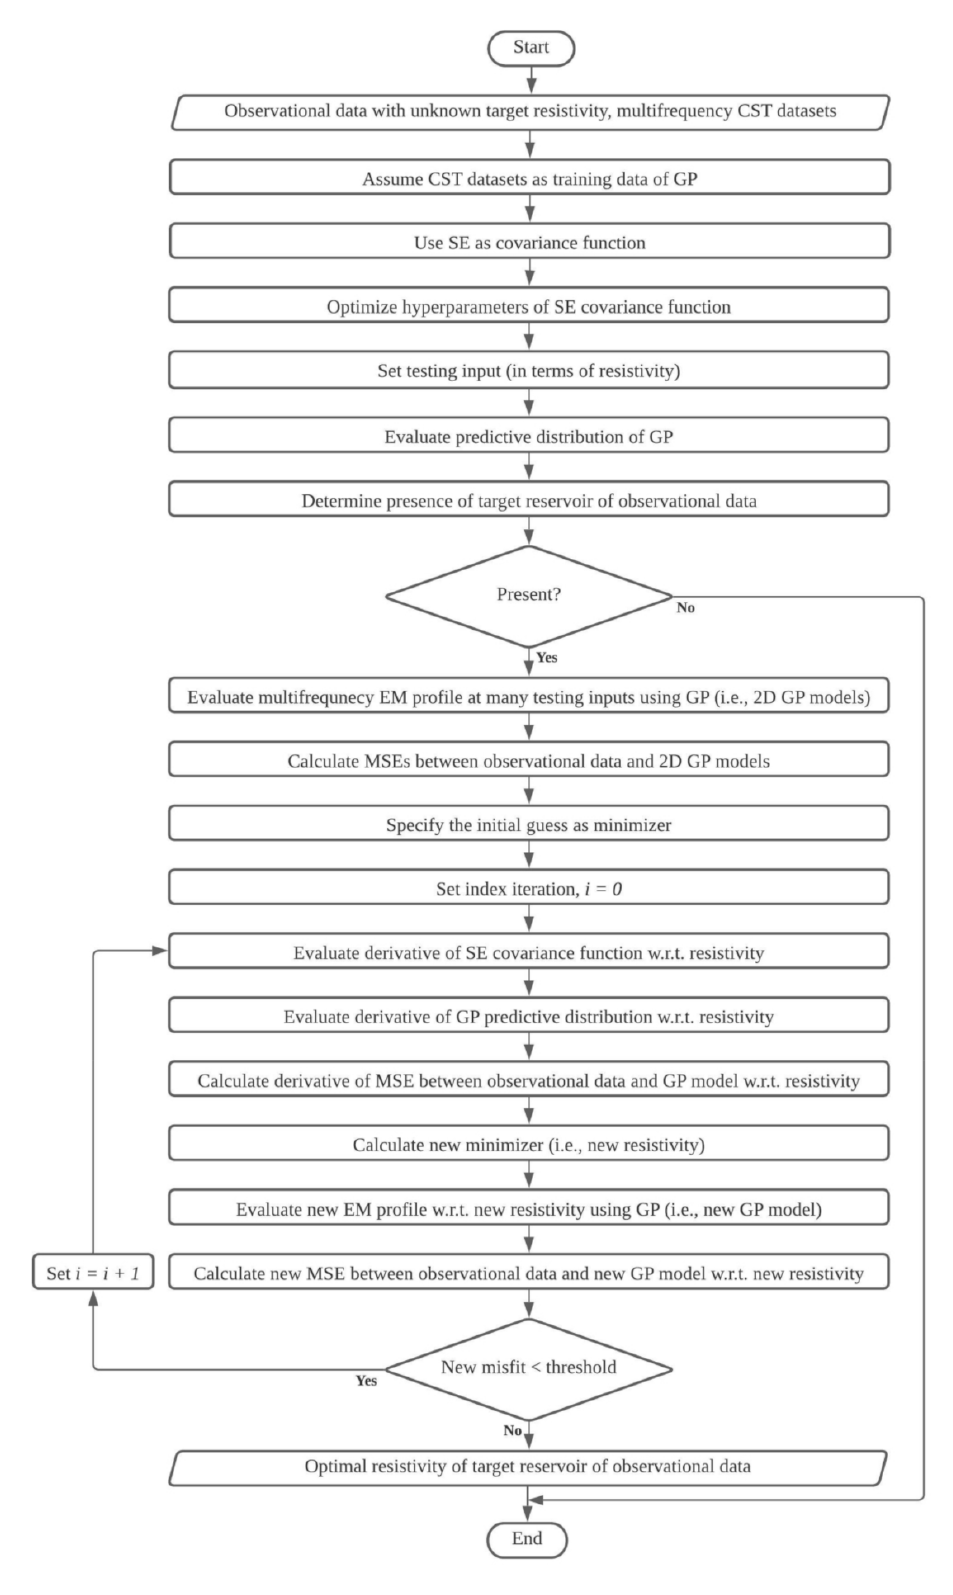
Figure 2. Methodological flow of the proposed methodology. In the context of this work, all the simulation models are models with presence of the hydrocarbon. Thus, the step of determining the target layer is not discussed in this work. w.r.t. indicates with respect